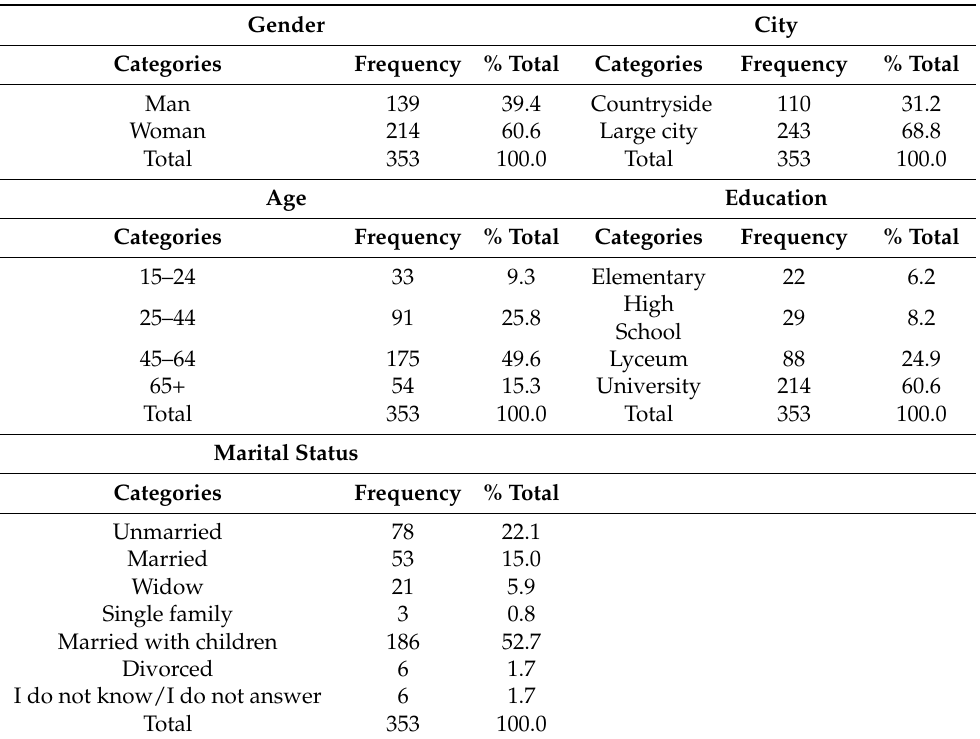
Table 1. Overview of the demographic variables of the sample.